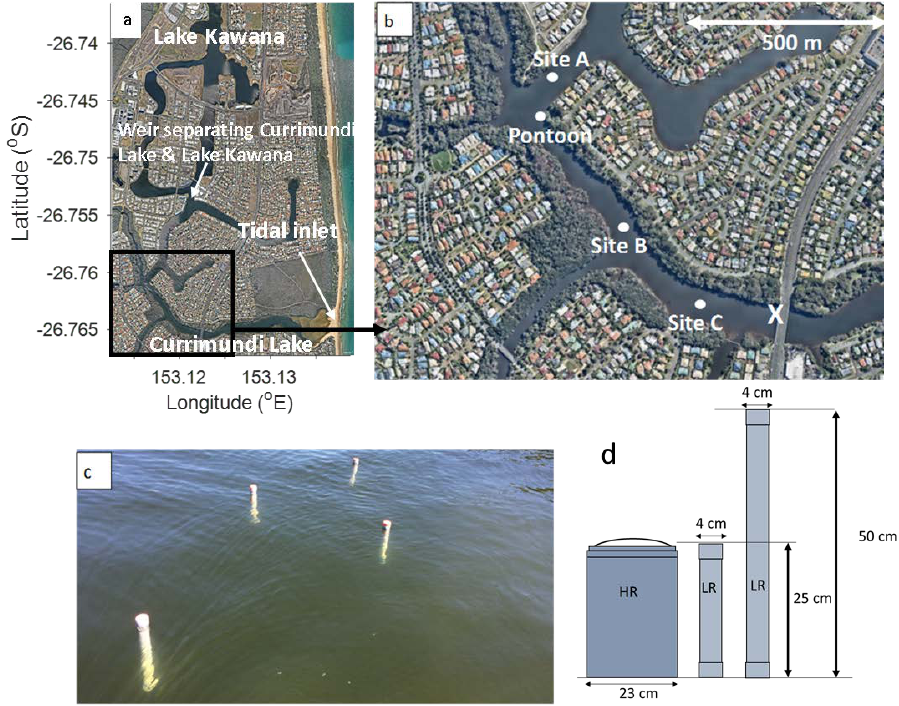
Figure 1. ( a ) Aerial view of Currimundi Lake catchment (Longitude 153.13° E, Latitude 26.763° S Nearmap, 2015); ( b ) Expanded view of the Currimundi Lake main channel; X—water quality monitoring station. ( c ) A cluster of four GPS-tracked drifters ~5 min after deployment. ( d ) Rendered drawing of the High (HR) & Low (LR) resolution drifters hulls.